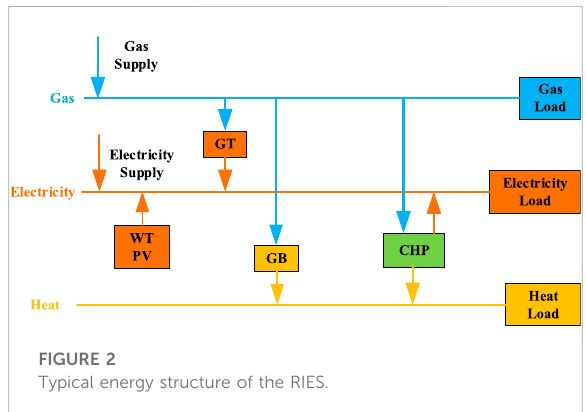
FIGURE 2 Typical energy structure of the